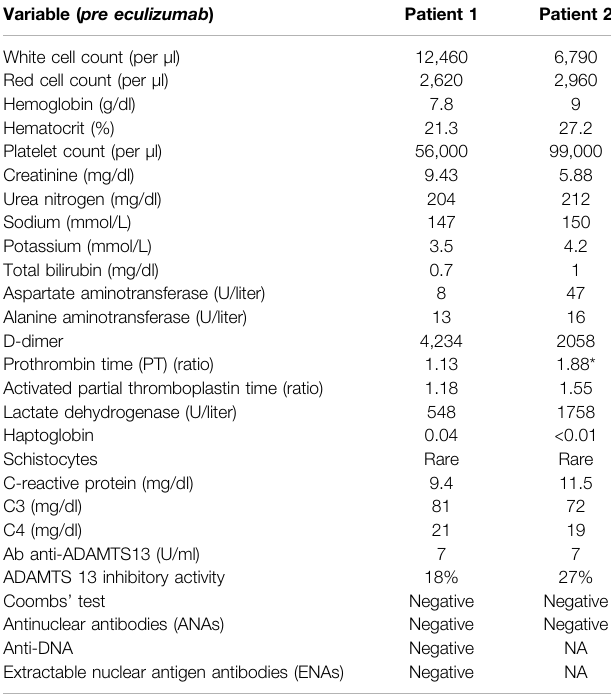
TABLE 1 | Laboratory values of the two patients at